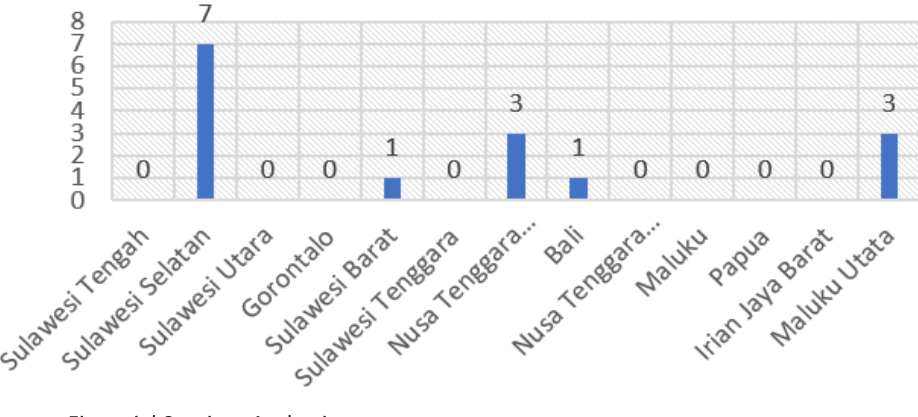
Figure 1: Number of Islamic Rural Banks in Eastern